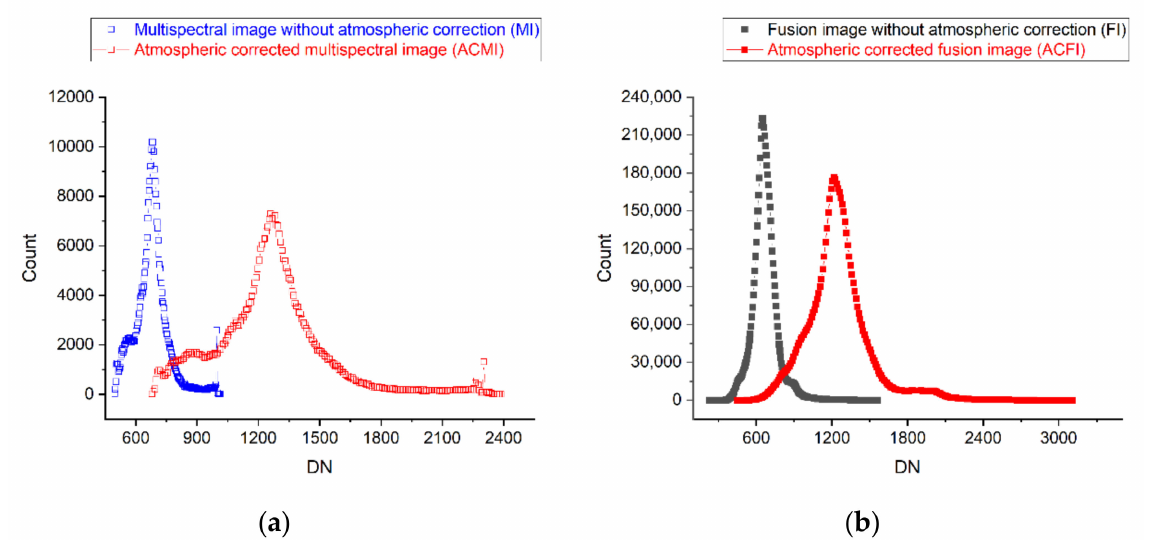
Figure 11. Effect of atmospheric correction on DN value of multispectral images and fusion images: ( a ) multispectral images; ( b ) fusion